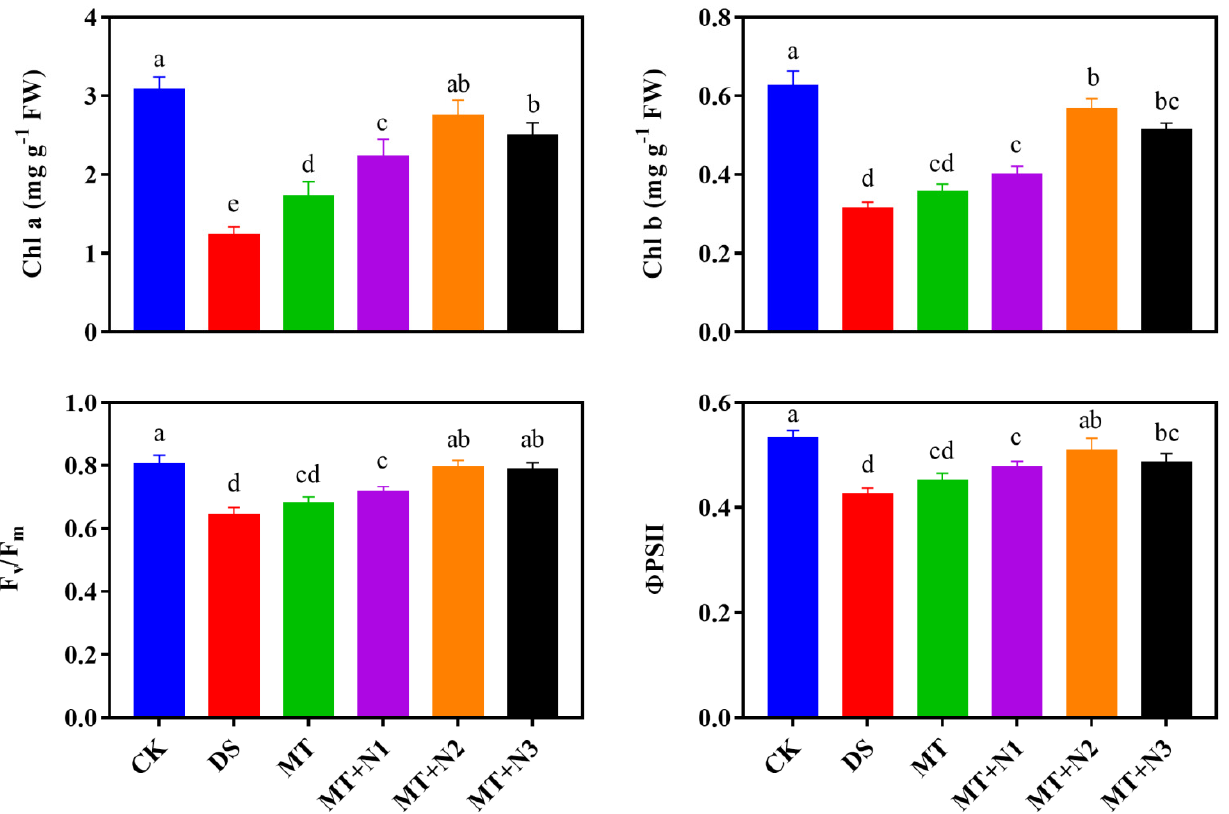
Figure 3. Chlorophyll a, b and chlorophyll fluorescence of maize seedlings under drought-stress conditions in combination with melatonin in different levels of nitrogen. CK; Well-watered control without melatonin (MT), DS; Drought stress without MT, MT; Drought stress + 100 µM MT, MT + N1; MT 100 µM + 200 kg N ha − 1 , MT + N2; MT-100 µM + 250 kg N ha − 1 , and MT + N3; MT-100 µM + 300 kg N ha − 1 . Vertical bars represent ± S.D. ( n = 3, biological replicates). Different letters indicate significant differences as determined by the LSD test ( p ≤ 0.05).